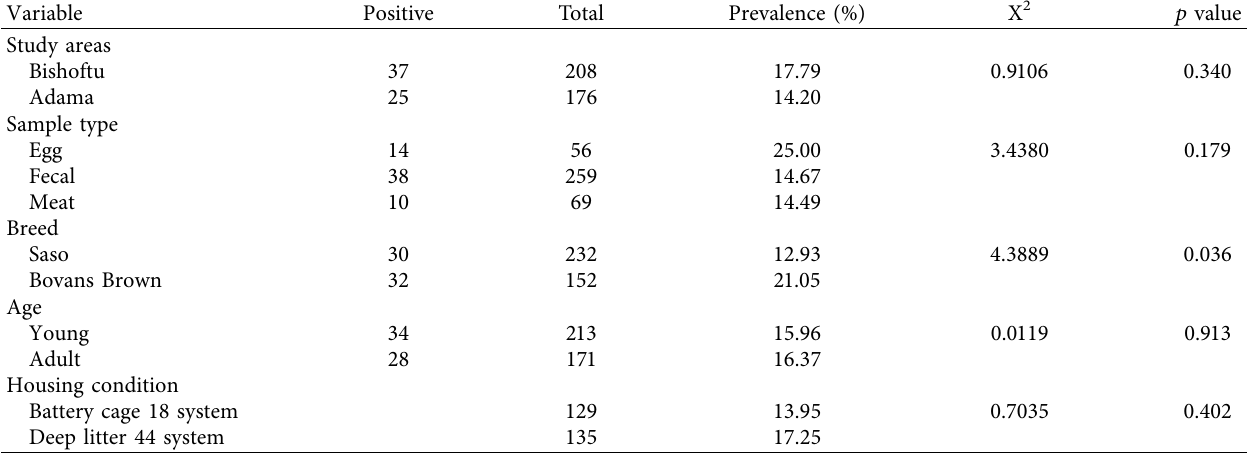
Table 1: Distribution of Salmonella isolates from diferent locations, breeds, ages, and housing conditions.